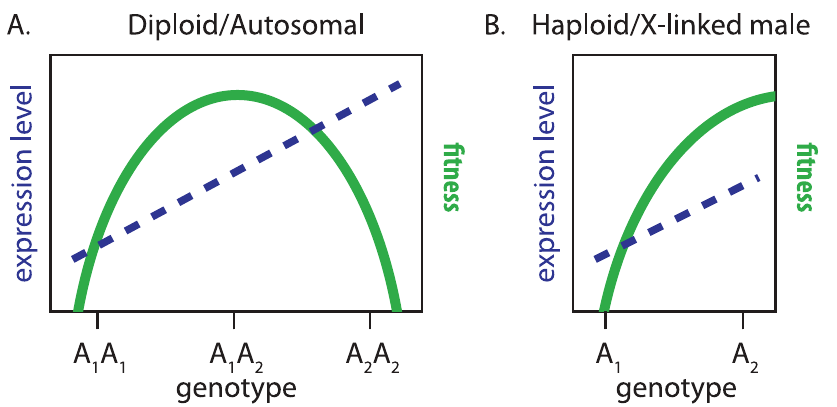
Figure 10. Additive phenotypic effects, fitness landscapes, and X-linkage. Expression level of a gene (dashed blue line) and relative fitness (solid green curve) are plotted for genotypes at a locus with two alleles ( A 1 and A 2 ). The alleles have additive phenotypic effects, with each copy of A 2 increasing expression level. (A) The locus is autosomal with phenotypic and fitness measurements collected in females or males, or it is X-linked with measurements collected in females. (B) The locus is X-linked and not dosage compensated with measurements collected in males.